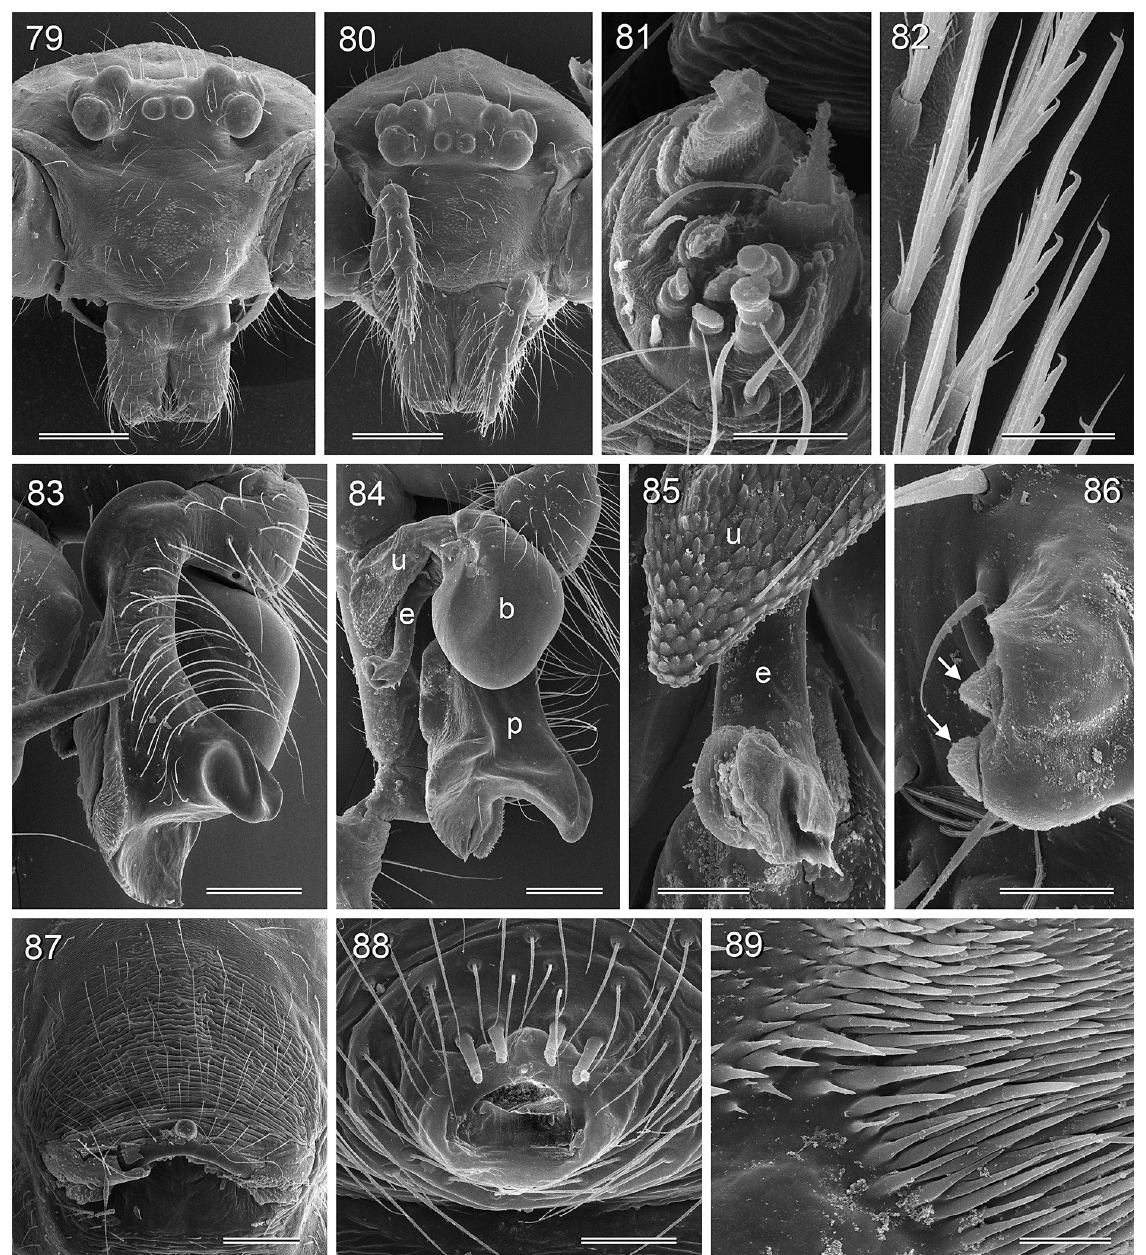
Figs 79–89. Pholcus sudhami Huber, 2011, ZFMK Ar 15031–32. 79–80 . Male and female prosomata, frontal views. 81 . Female ALS. 82 . Comb-hairs on male tarsus 4. 83 . Right procursus, retrolateral (slightly distal) view. 84 . Left bulb and procursus, prolateral view. 85 . Left uncus and embolus, prolateral view. 86 . Male distal cheliceral apophysis (arrows point at modified hairs). 87 . Epigynum, ventral view. 88 . Male gonopore. 89 . Pseudotrichia on ventral side of procursus. Abbreviations: b = genital bulb; e = embolus; p = procursus; u = uncus. Scale lines: 20 µm (81–82, 86); 30 µm (89); 50 µm (88); 60 µm (85); 200 µm (83–84, 87); 300 µm